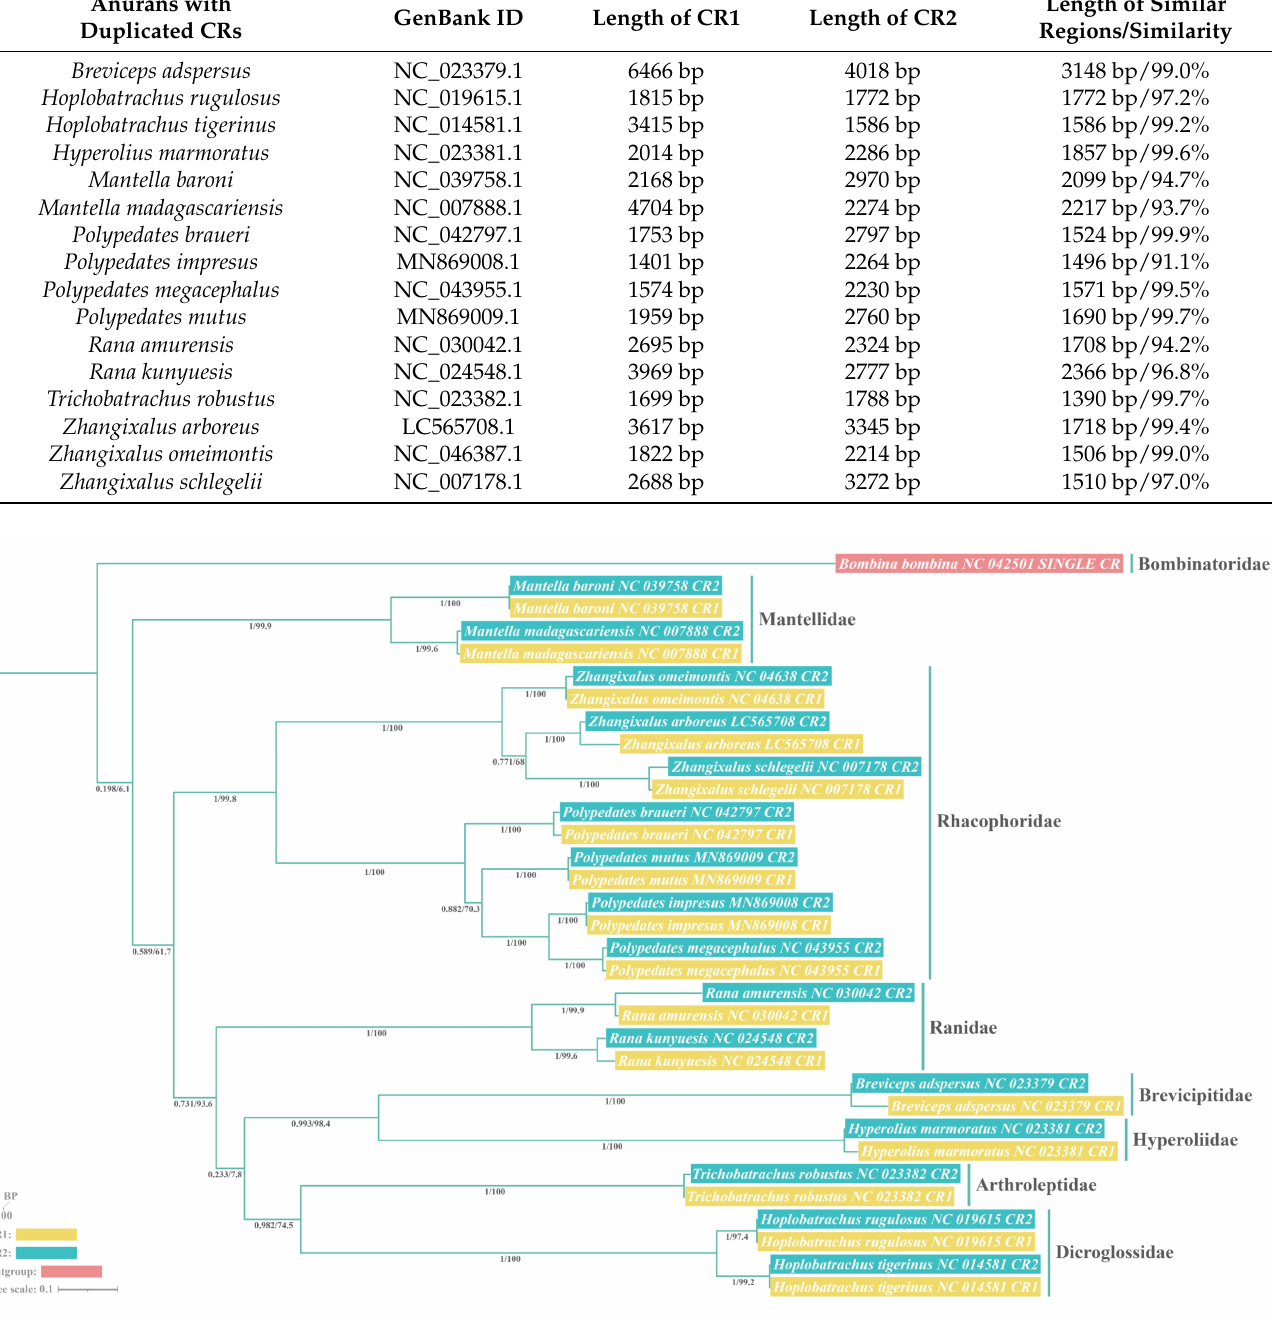
Figure 6. Phylogenetic tree based on control region (CR) sequences of 16 anurans with duplicated CRs. Bombina bombina with only a single CR was selected as the outgroup. Both maximum likelihood (ML) and Bayesian inference (BI) analyses yielded identical topologies with comparable branch support. Paralogous CRs were always clustered together with strong node support, indicating that the duplicated CRs within those individuals were evolved in